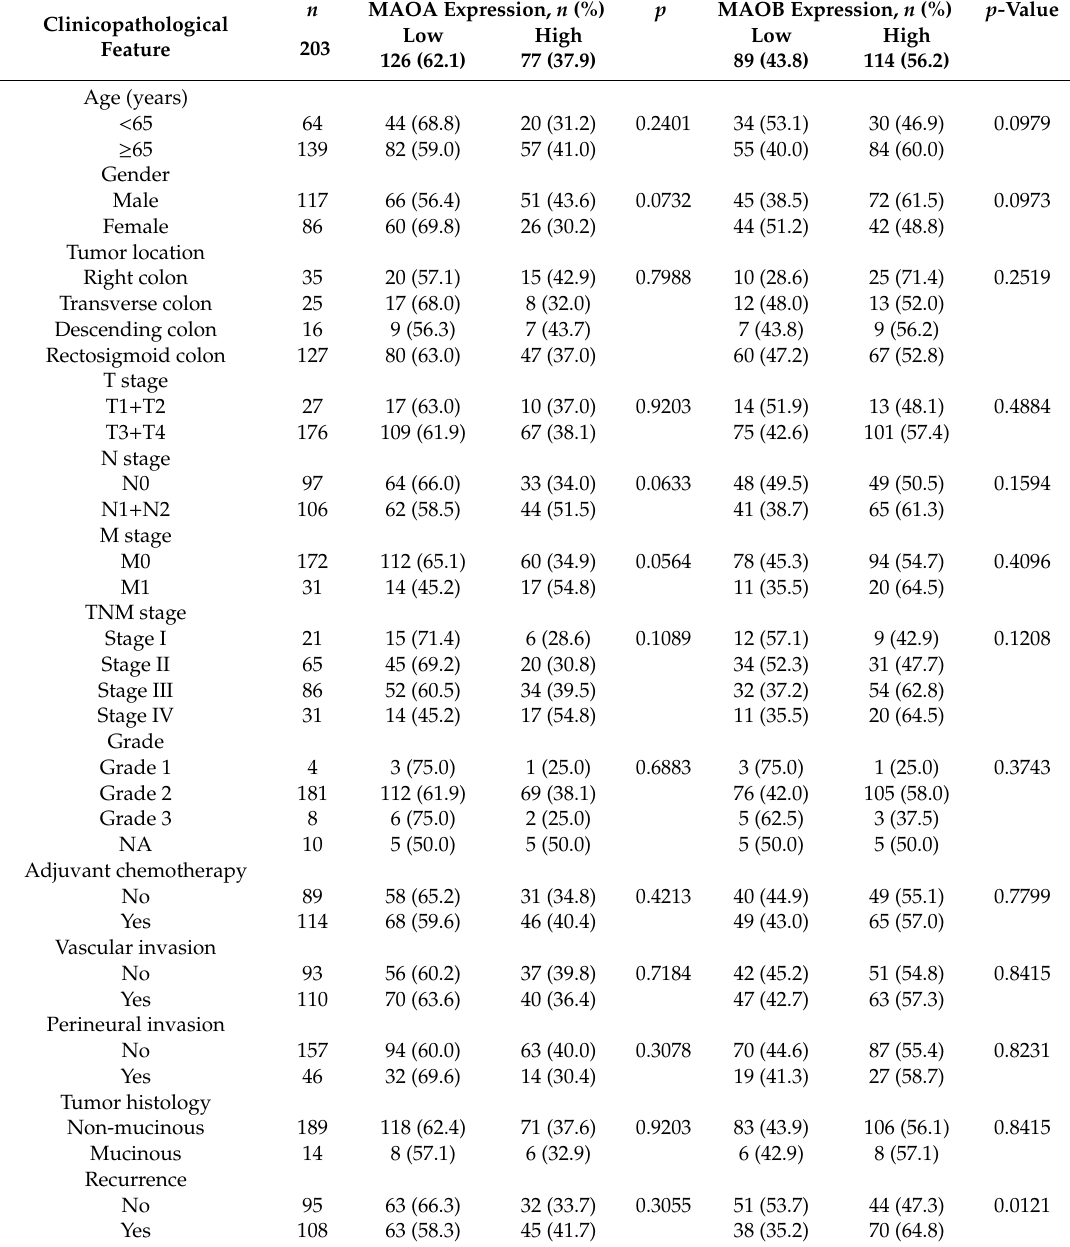
Table 1. Correlations of clinicopathological features of colorectal cancer patients and tumor expressions of monoamine oxidase A (MAOA) and